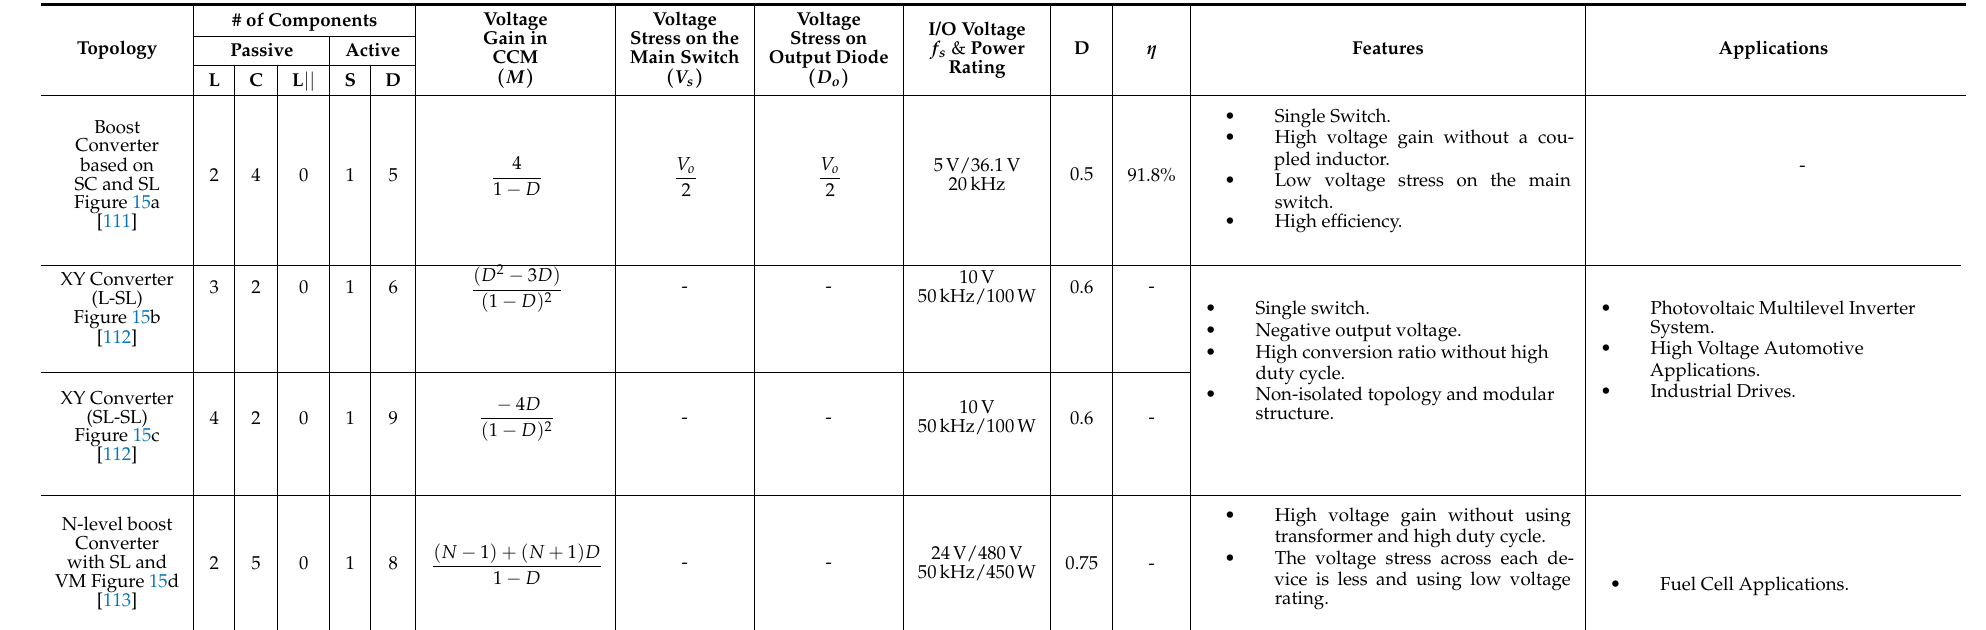
Table 8. Comparison of Switched Inductor (SL)